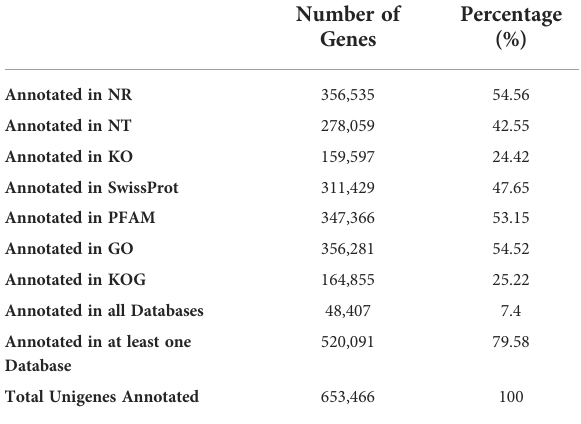
TABLE 2 Blast analysis of assembled